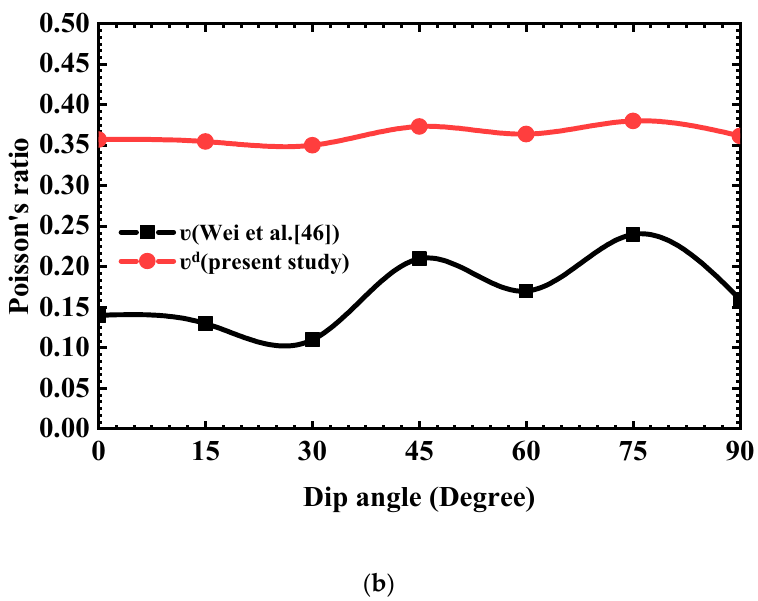
Figure 8. The anisotropic strength parameters for different dip angles: ( a ) Elastic modulus; ( b ) Poisson’s ratio.